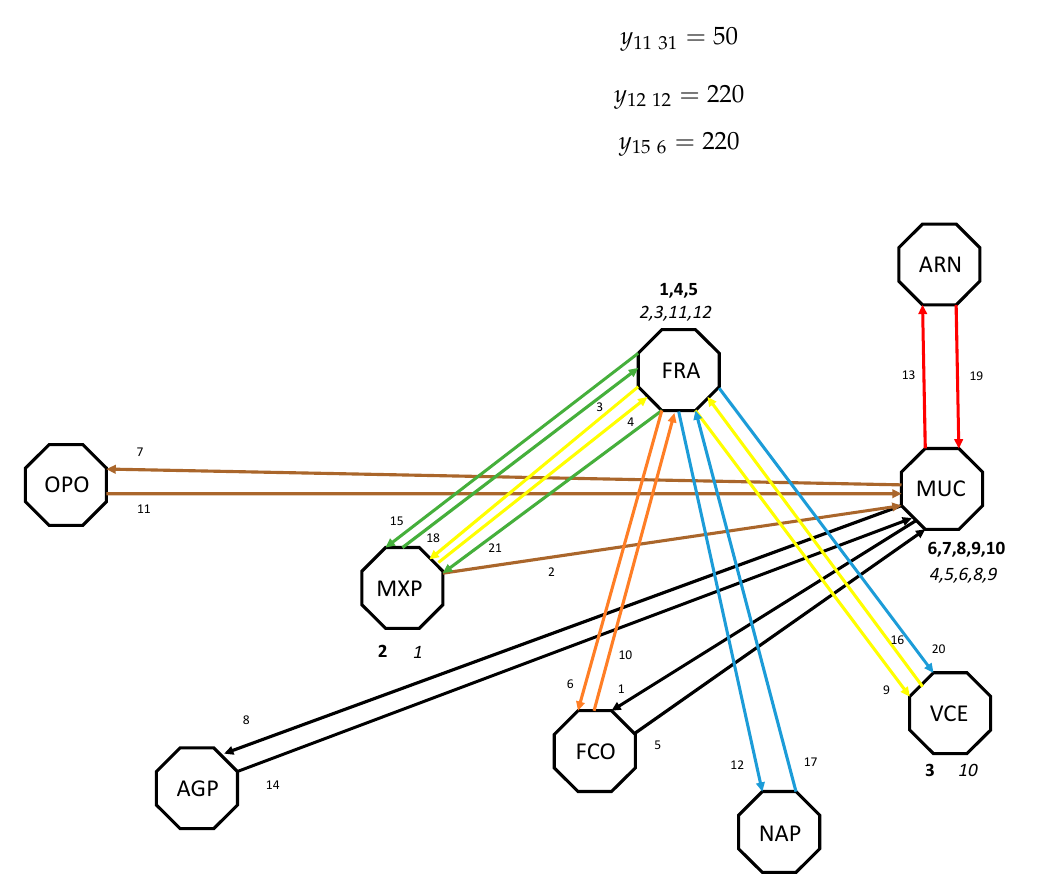
predefined values of variables y jk , see constraints 23, 24 and 25.